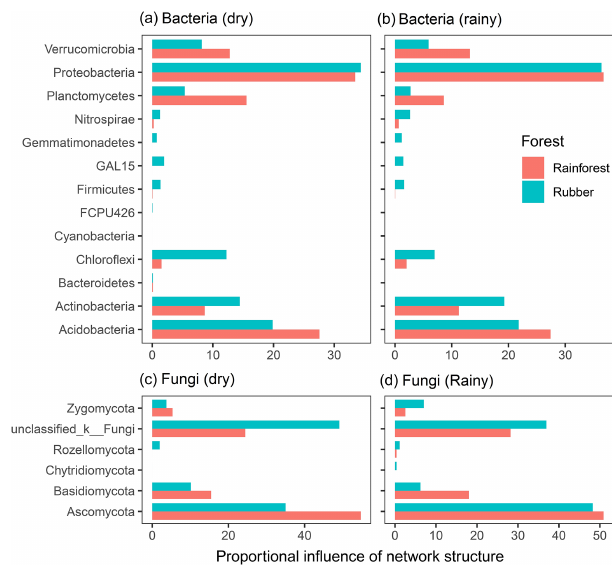
Figure 7. The proportional influence of different phyla on the bac- terial and fungal network structure in both the dry and rainy sea- sons. The influence was the number of degrees of nodes belonging to a particular phylum: panel (a) shows bacteria in the dry season, panel (b) shows bacteria in the rainy season, panel (c) shows fungus in the dry season and panel (d) shows fungus in the rainy